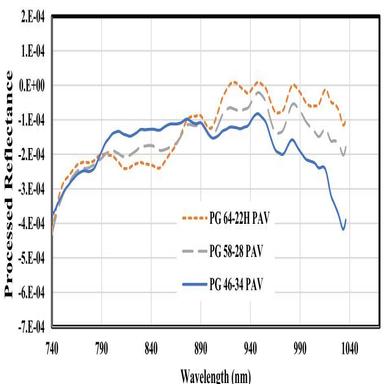
Comparison of the PG 58-28 neat binders with different percentages of rubber.